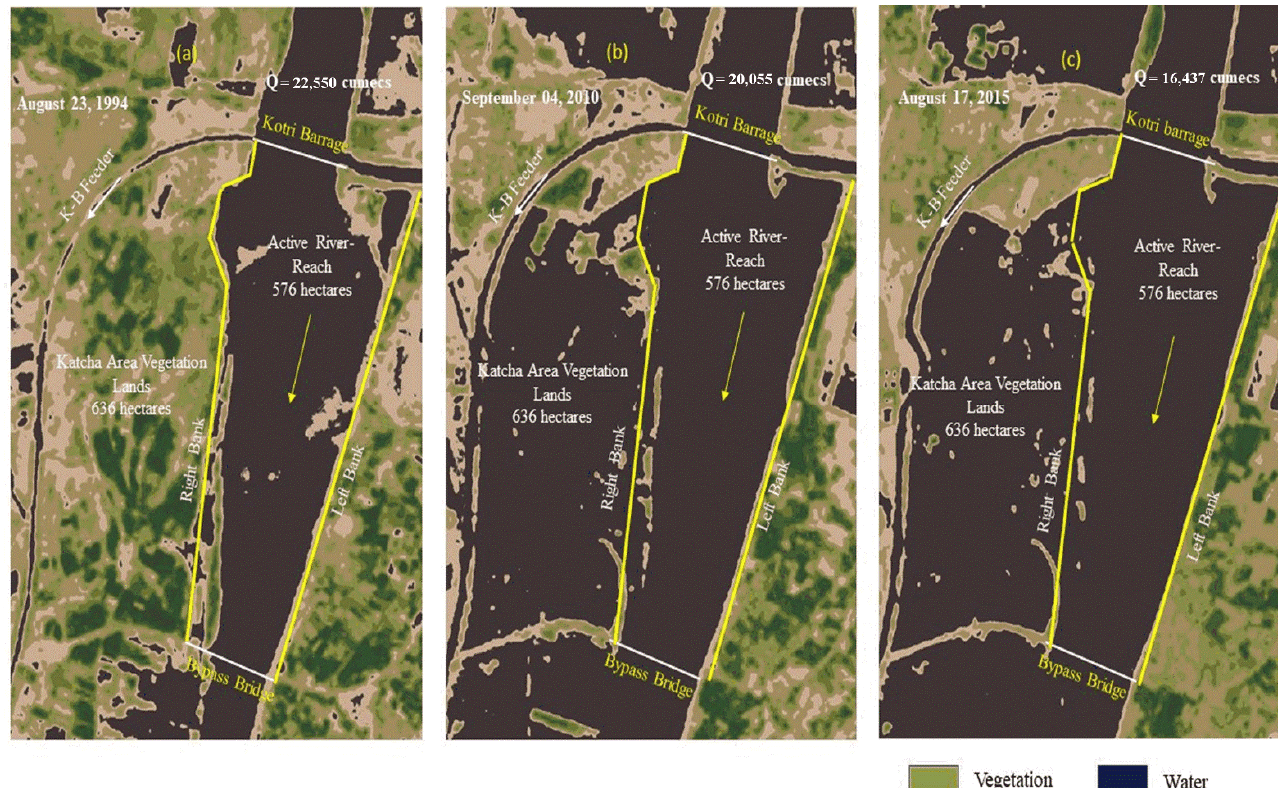
Figure 5. Visual comparisons of Landsat imageries for the study area river-reach. ( a ) TM acquired image on 23 August 1994, passing an exceptionally high flood through active river-reach; ( b ) TM acquired image on 4 September 2010, showing the inundation of Katcha area along with active reach at very high flood; ( c ) OLI and TIRS acquired image on 17 August 2015, depicting the inundation of Katcha area and active river-reach at high flood passing downstream of the Kotri barrage.